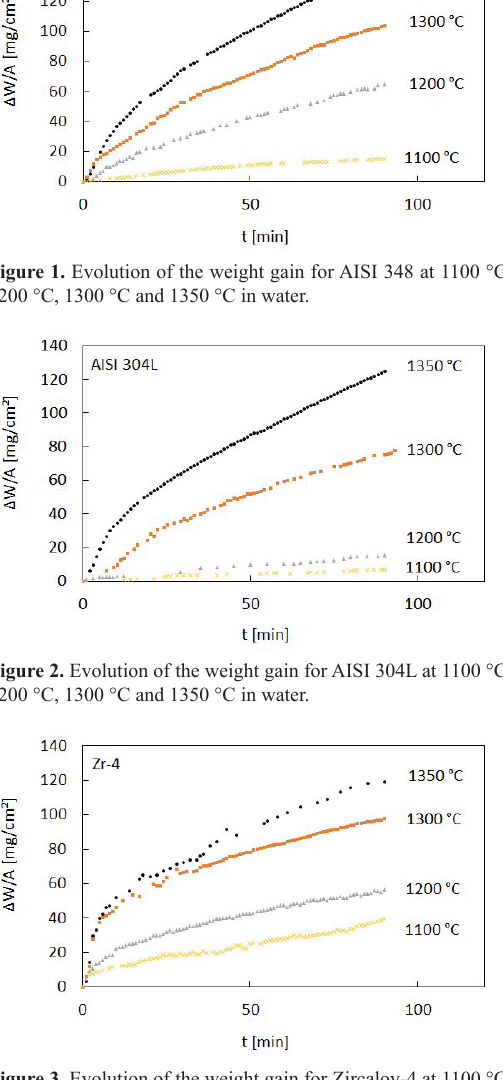
Figure 3. Evolution of the weight gain for Zircaloy-4 at 1100 °C, 1200 °C, 1300 °C and 1350 °C in